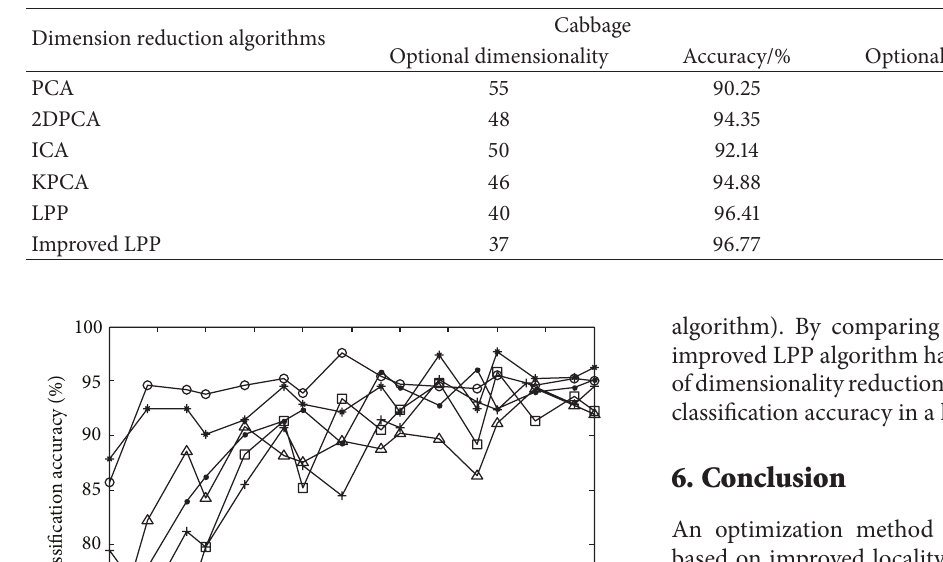
Table 3: Performance comparison among algorithms.